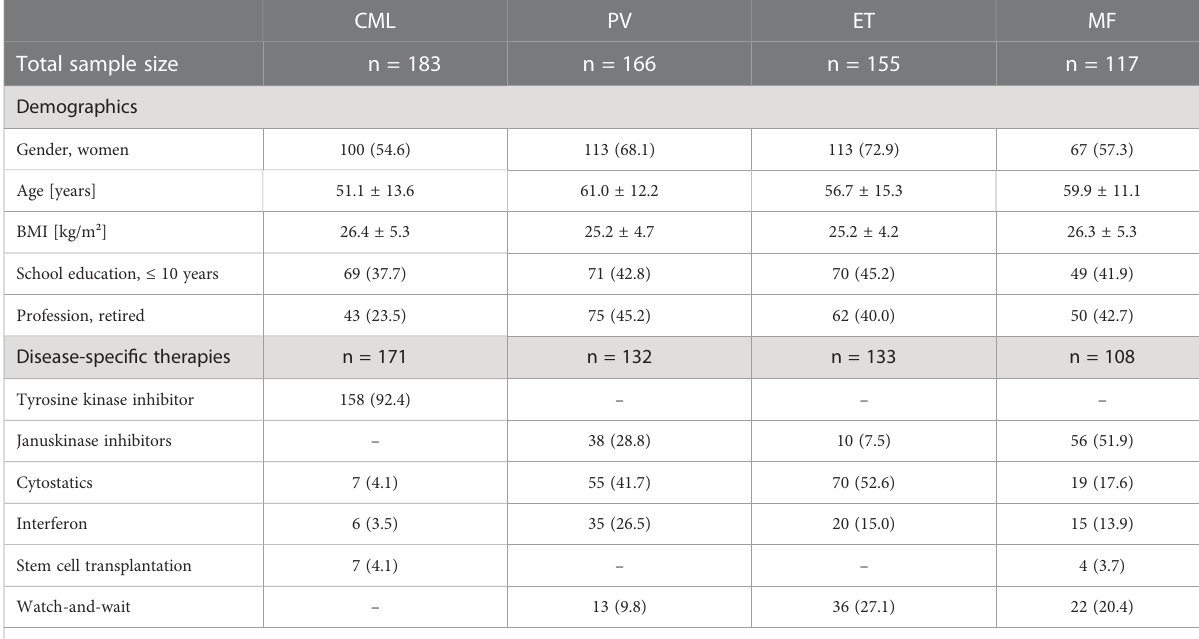
TABLE 2 Demographics and current therapies of patients with myeloproliferative neoplasms depending on the